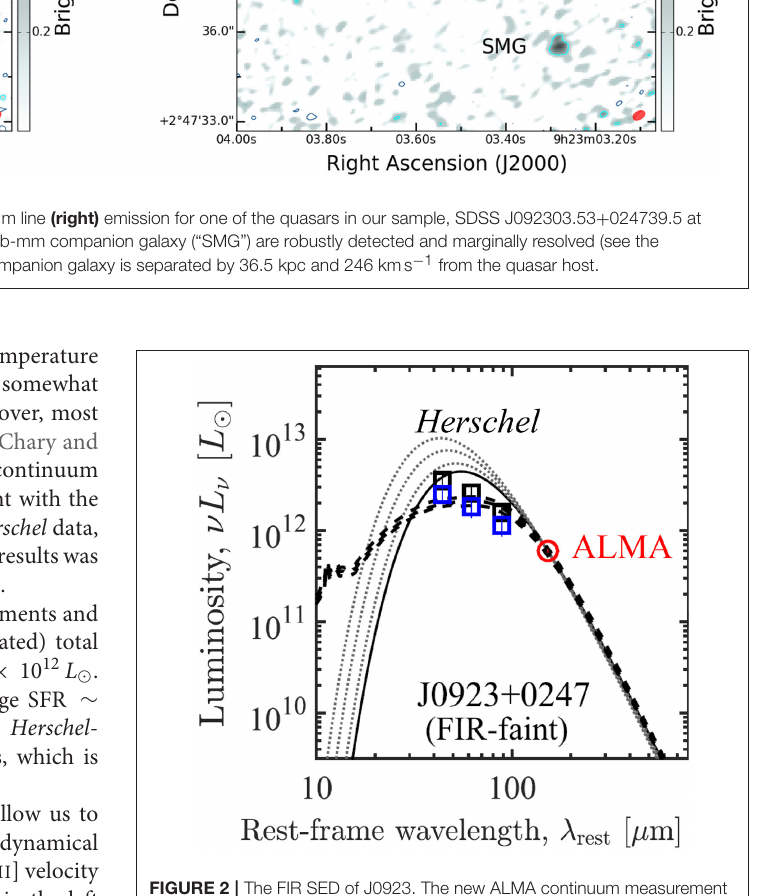
FIGURE 2 | The FIR SED of J0923. The new ALMA continuum measurement (red) is broadly consistent with the previous Herschel data (based on stacking analysis; black squares). Blue squares show the Herschel data after correcting for the fraction of the flux that comes from the companion galaxy. The solid black line traces a gray-body SED with T d = 47 K and β = 1.6, while the dotted lines trace different temperatures. The dashed lines illustrate several relevant templates from Chary and Elbaz